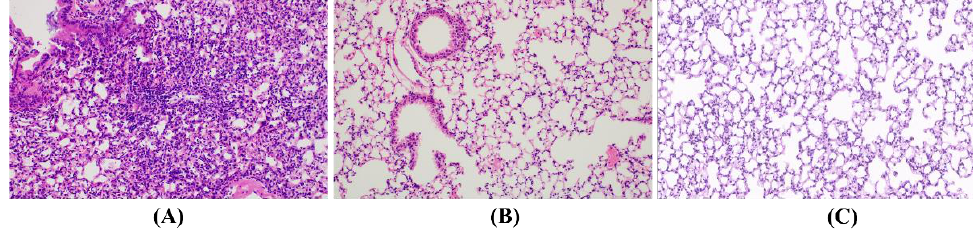
Figure 4. Histopathological analysis of lungs in each group. ( A ) A histopathological section of a mouse lung treated with PHMG shows inflammatory cells infiltrating the alveoli (H&E, X200), ( B ) a tissue section of mouse lung treated with PBS, which serves as a negative control (H&E, X200), ( C ) the control group, which did not receive any treatment (H&E, X200) in the mouse model.